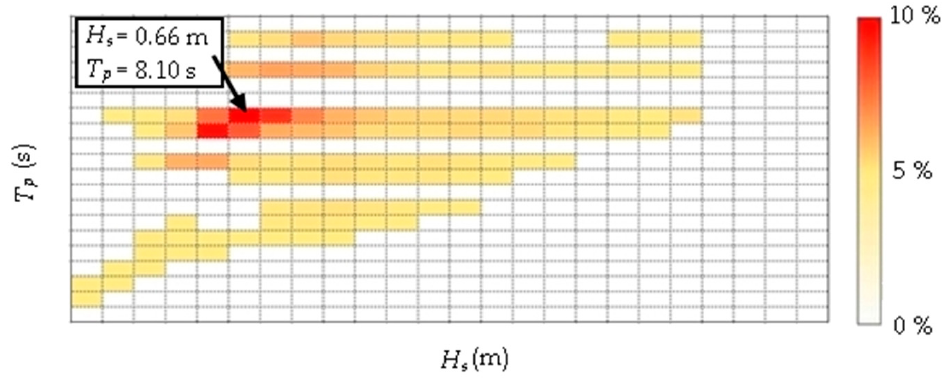
Figure 2. Histogram of frequency of occurrence of sea state for the point referring to RG.